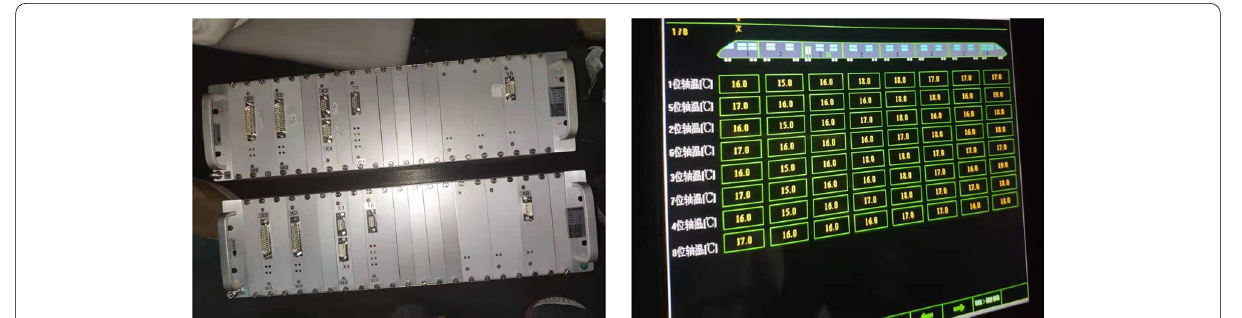
Figure 11 Acquisition instrument and temperature display